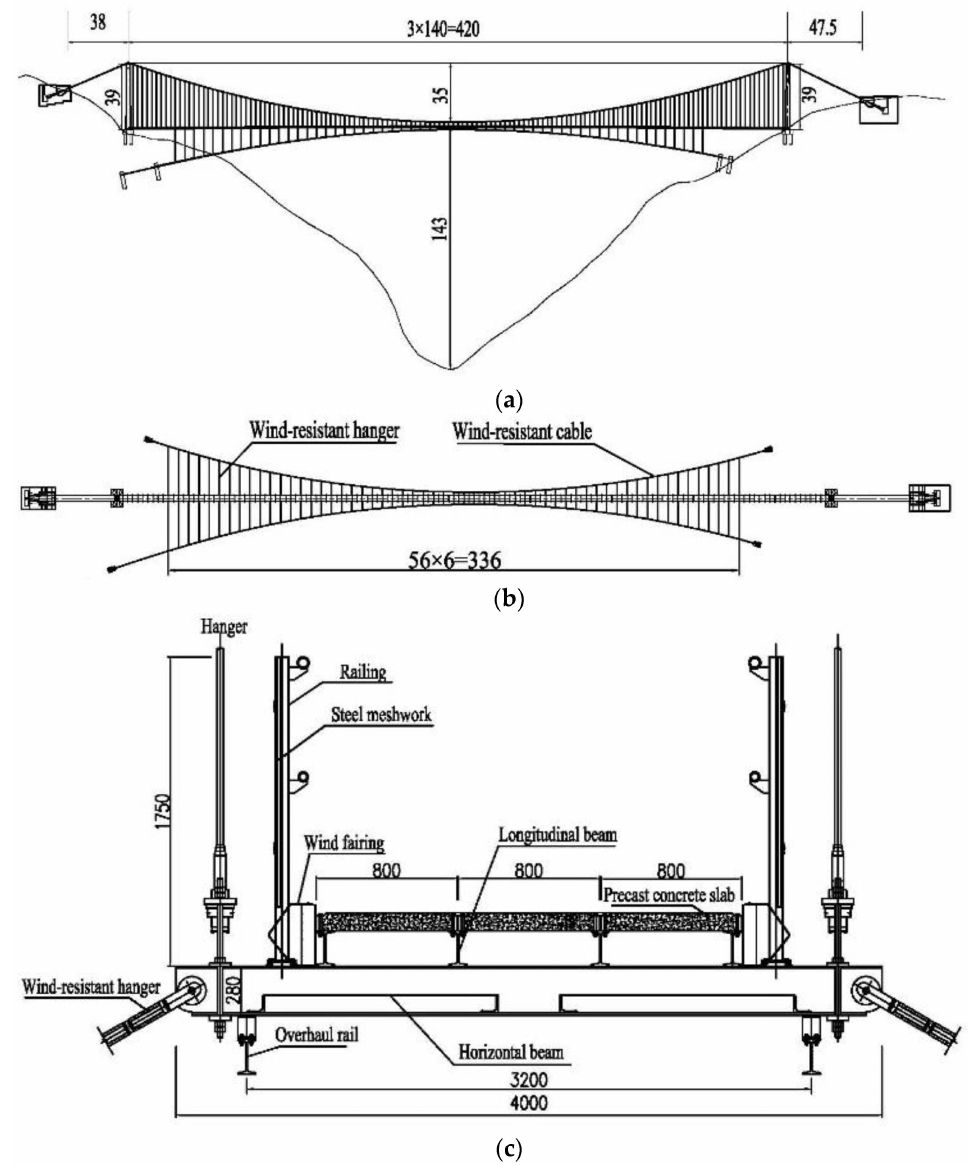
Figure 2. Configurations of the Tianmeng Bridge: ( a ) Elevation (m); ( b ) Deck level plan (m); ( c ) Girder cross section